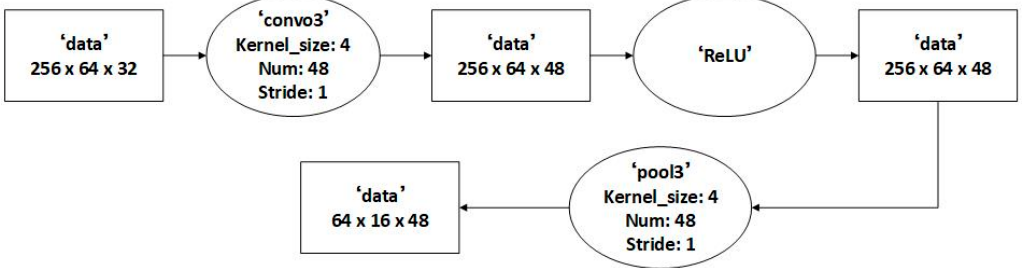
Figure 7. Convo3 convolutional layer process.